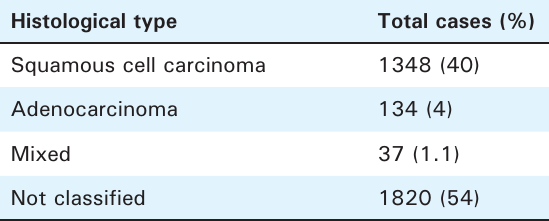
Table 3. Distribution according to Histological